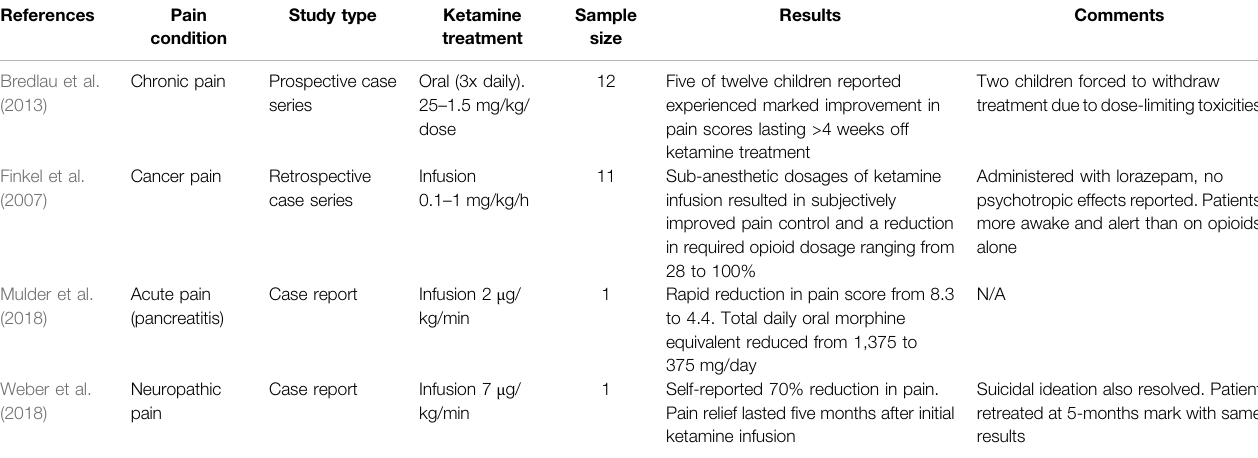
TABLE 3 | Compiled evidence of ketamine ’ s analgesic effect in the pediatric